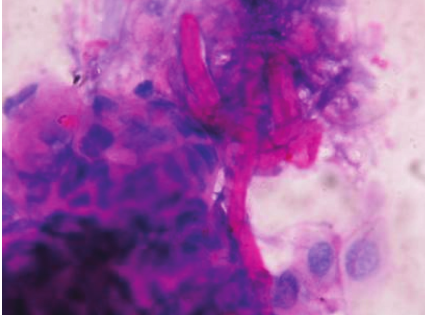
Figure 3: PAS positive fungal hyphae between corneal epithelial